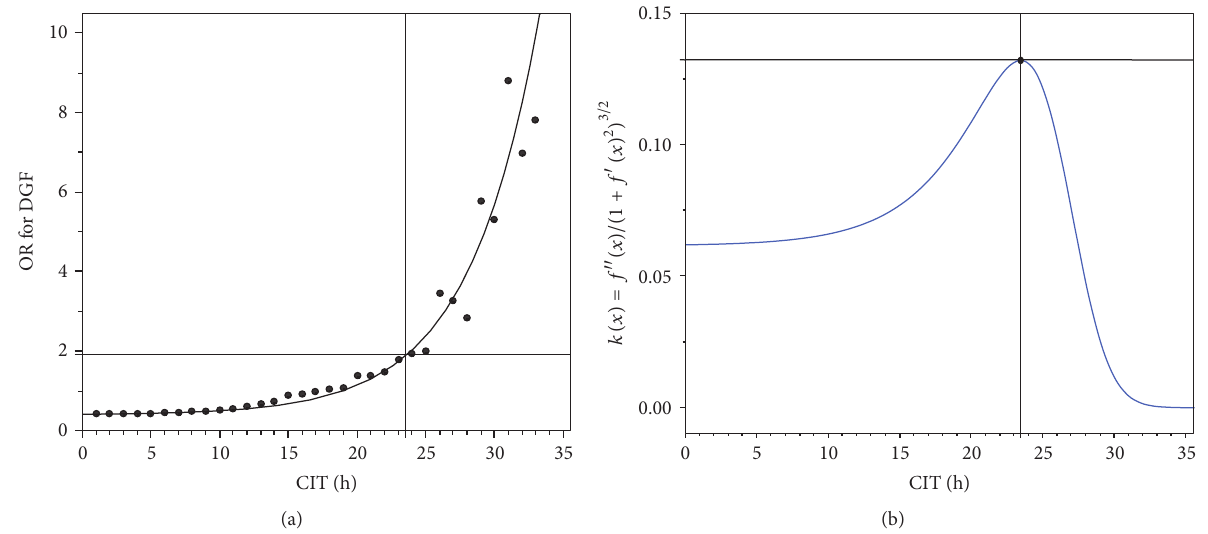
Figure 2: (a) Increments of odds ratios (OR) for delayed graft function were calculated and plotted per increment of CIT-hours. A mechanistic asymptotic regression function 𝑓(𝑥) = 𝐴 ⋅ (1 + 𝑘 ⋅ 𝑒 (𝐼⋅𝑥) ) ( 𝐴 = asymptotic, 𝑘 = scale, and 𝐼 = increment) with best estimated fit was chosen for further calculations. The function 𝑓(𝑥) = 0.4175662 ⋅ (1 + 0 , 035169 ⋅ 𝑒 (0.196467⋅𝑥) ) (black line) was finally identified with lowest SSE = 10.3141 and best 𝑅 2 = 0.94 (a). (b) The point of highest acceleration in risk increment was then calculated by insertion of the regression equation 𝑓(𝑥) = 0.4175662 ⋅ (1 + 0 , 035169 ⋅ 𝑒 (0.196467⋅𝑥) ) into the curvature formula 𝑘(𝑥) = 𝑓 󸀠󸀠 (𝑥)/(1 + 𝑓 󸀠 (𝑥) 2 ) 3/2 with 𝑘 max . = 0.13 to 23.5 hours at an odds ratio of 1.9 (cross hairs at black (a) and blue lines (b)). The calculated CIT cut-off of 23.5 h was then used in univariable regression analysis to calculate the risk of delayed graft function development for CIT > 23.5 h to a hazard ratio of 3.713 (CI 2.215–6.225; 𝑝 < 0.001